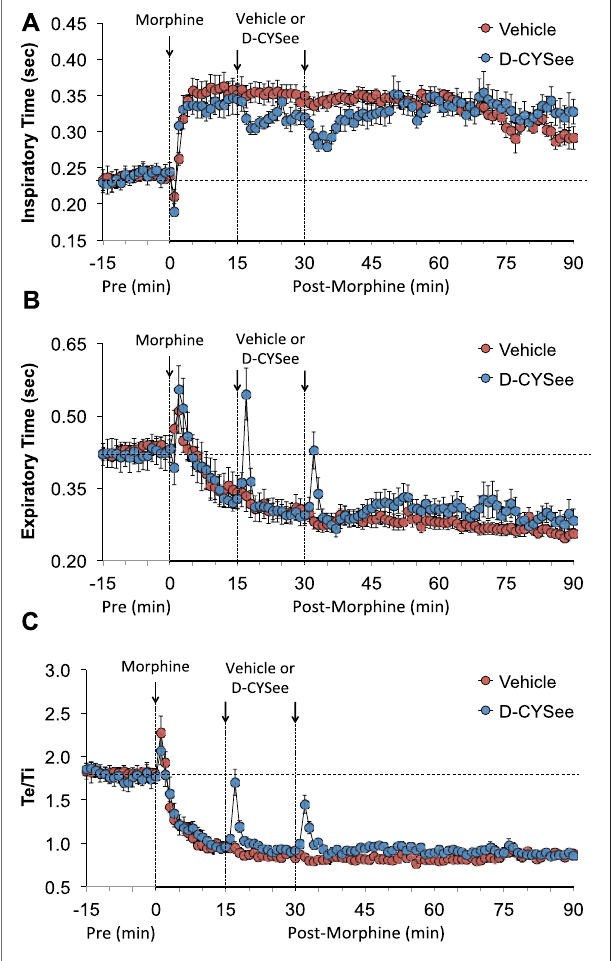
FIGURE 2 | Values of inspiratory time (Panel (A) ), expiratory time (Panel (B) ), and expiratory time/inspiratory time (Te/Ti) (Panel (C) ) in freely-moving rats prior to (pre) and following injection of morphine (10 mg/kg, IV) and subsequent injections of vehicle (saline, IV) or D-cysteine ethyl